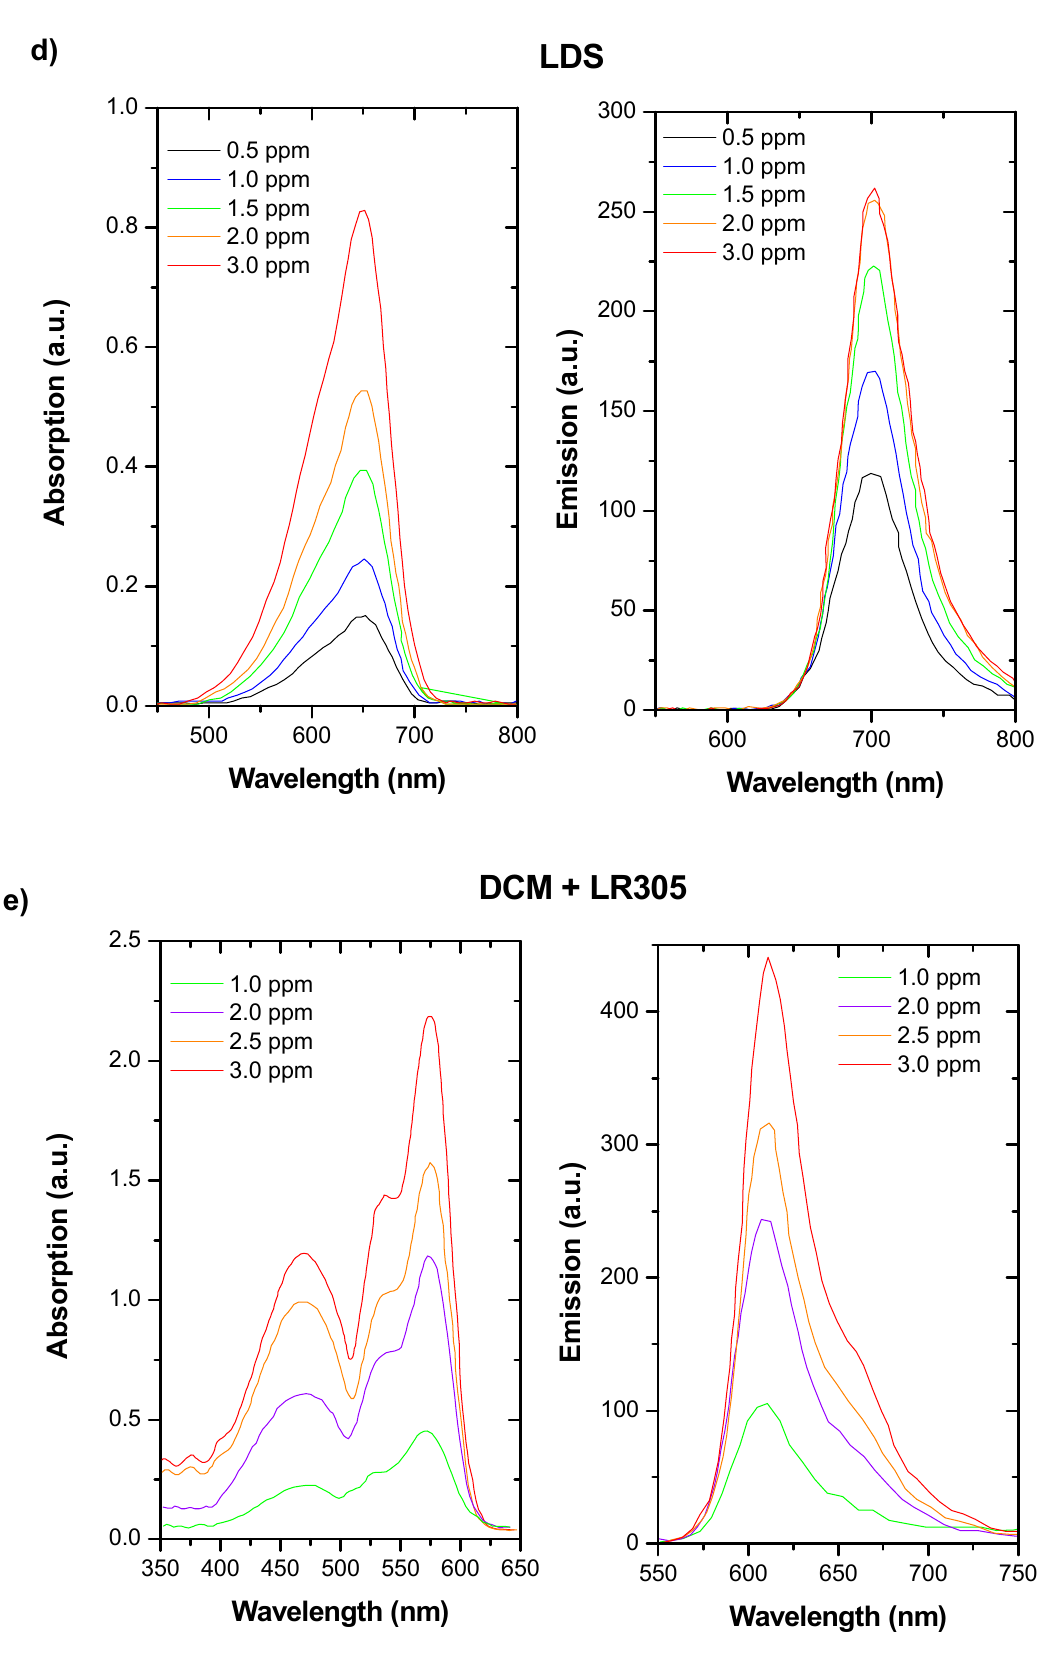
Figure 3. Absorption and emission spectra obtained for different dyes: ( a ) DCM, ( b ) LR305, ( c ) LDS, ( d ) DCM + LDS, and ( e ) DCM + LR305. Emission peaks were aligned with PAR requirements, and combination of DCM + LDS offered the advantage of wider absorption